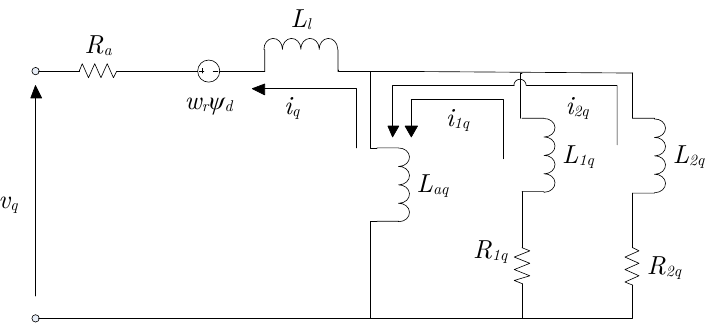
Figure 3. Synchronous machine equivalent electrical circuit: quadrature